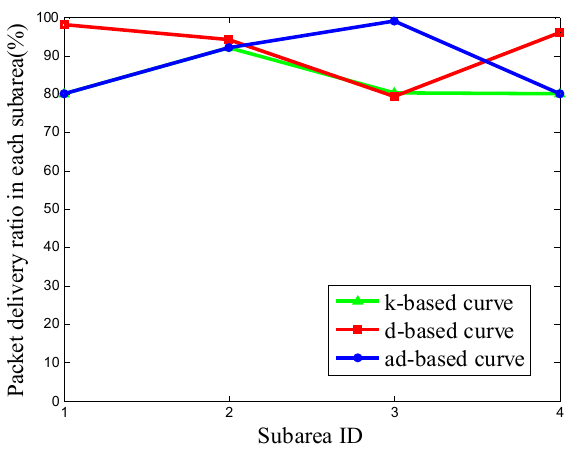
Figure 11. The PDR of k-based, d-based and adjustable d-based curve in node deployment (a) in Scenario 2.